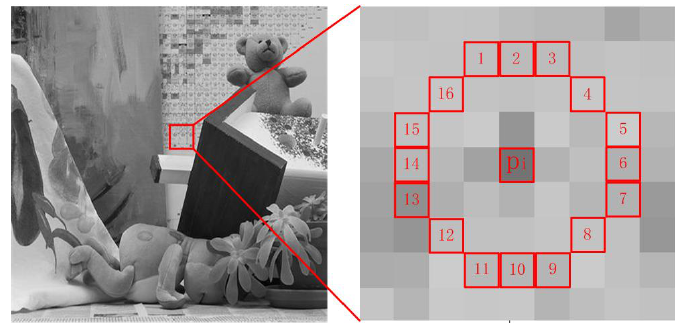
Figure 6. Bresenham discrete circle centered on pixel p i